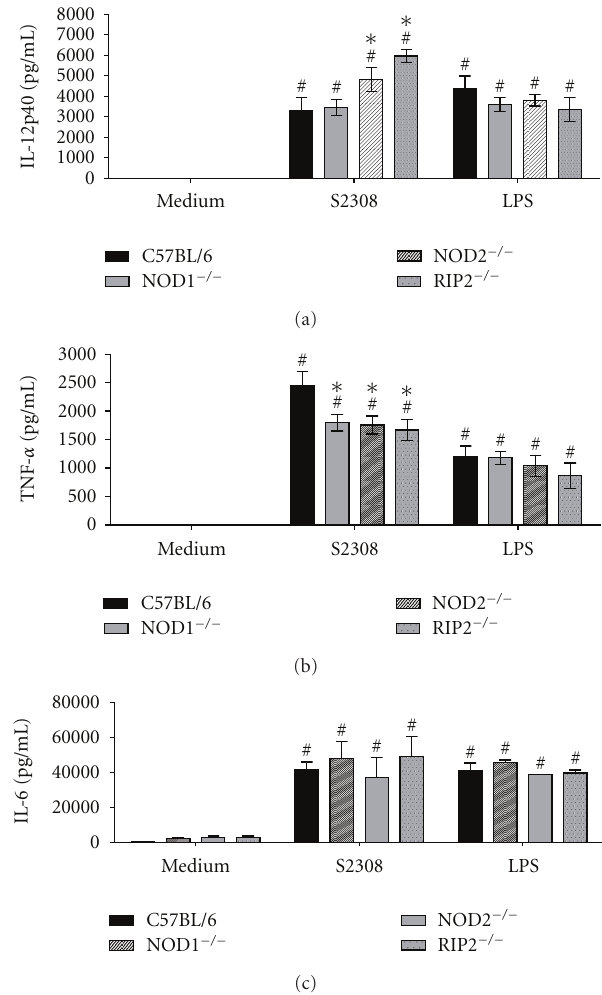
Figure 3: TNF- α production induced by B. abortus in macrophages, but not IL-12 and IL-6, requires NOD1, NOD2, and Rip2. Bone marrow from C57BL/6, NOD1 − / − , NOD2 − / − , and RIP2 − / − mice cells was di ff erentiated in macrophages and stimulated with B. was harvested for measuring IL-12 (a), TNF- α (b), and IL-6 (c) after 24hrs by ELISA. Statistically significant di ff erence in relation to non-stimulated cells is denoted with # and in relation to C57BL/6 mice is denoted with an asterisk ( ∗ ). The significance of di ff erences was compared by ANOVA followed by Tukey’s test ( P < 0 .